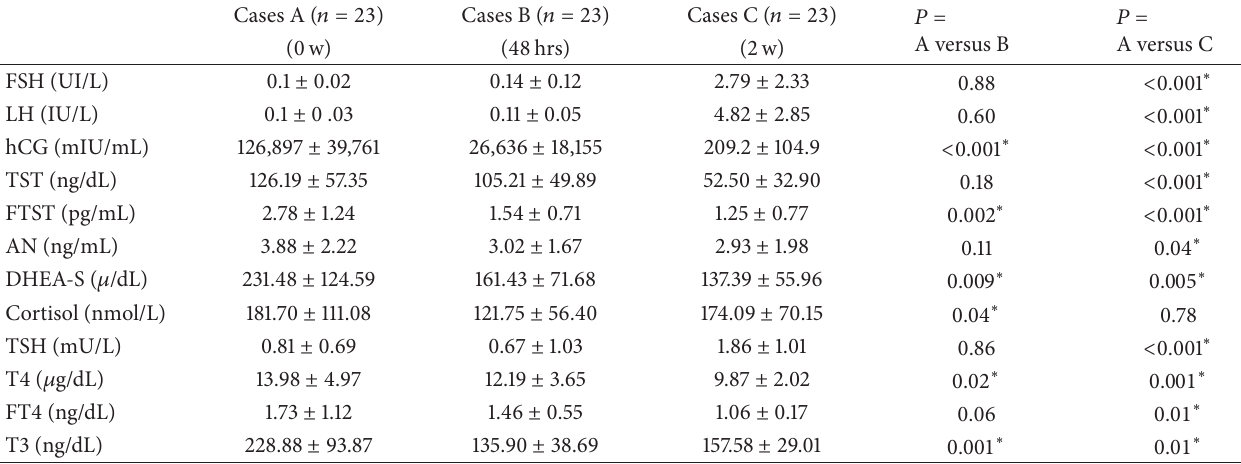
Table 3: Hormonal assessment before and after HM evacuation.